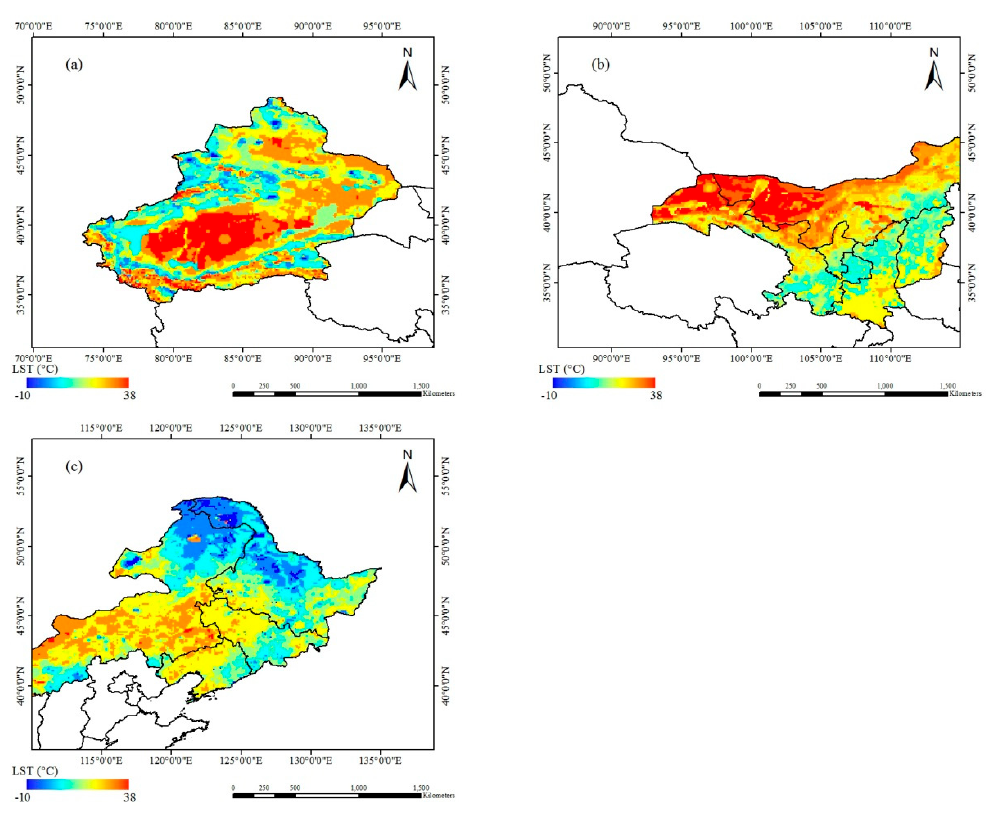
Figure 6. Spatial distribution of LST from the CNN results in Xinjiang ( a ), midwest Inner Mongolia ( b ) and Northeast China ( c ).